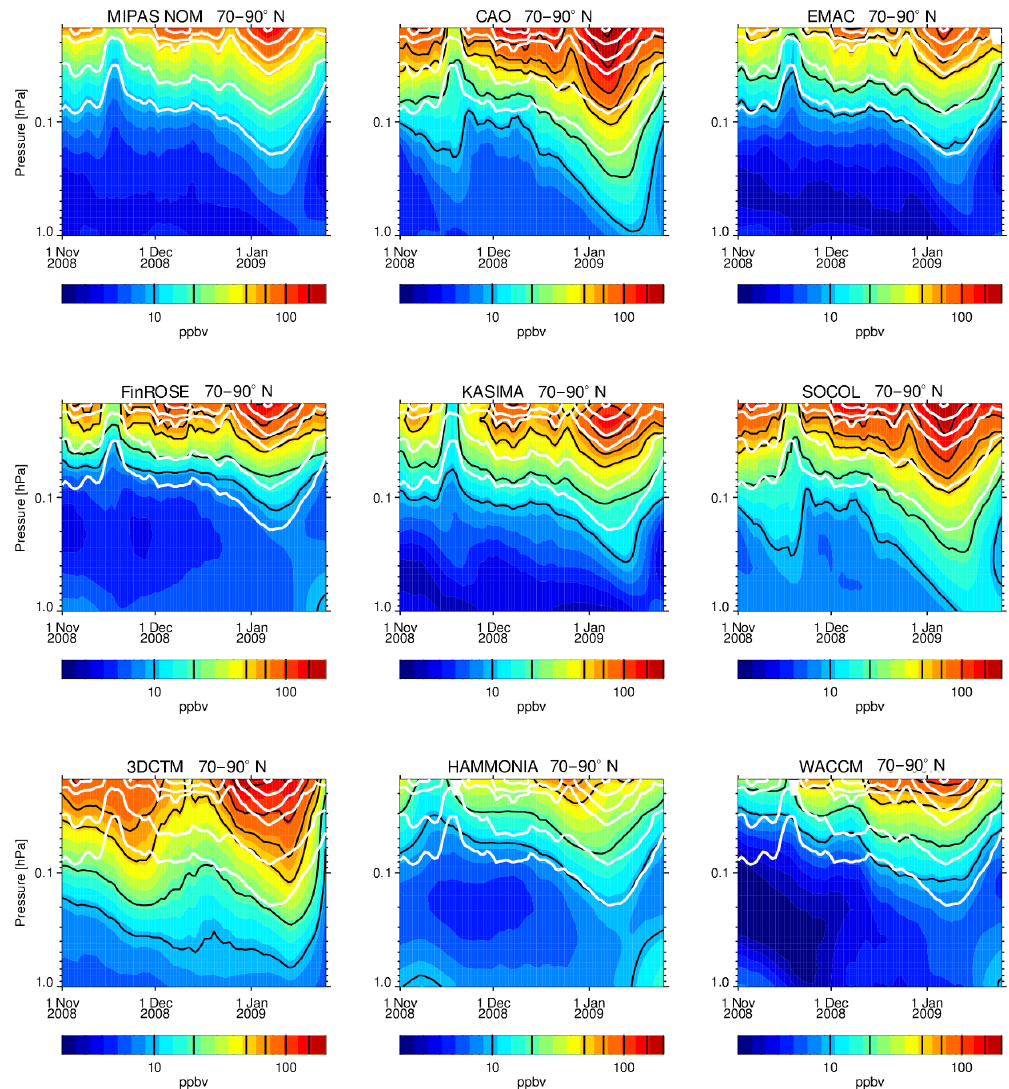
Figure 12. MIPAS-NOM and modelled temporal evolutions of NO x in the pre-SSW phase of the 2008/09 NH winter at 1–0.02hPa within 70–90 ◦ N. White lines indicate the observed VMR levels of 10, 20, 50, 70, 100, and 150ppbv. White regions reflect missing or not meaningful